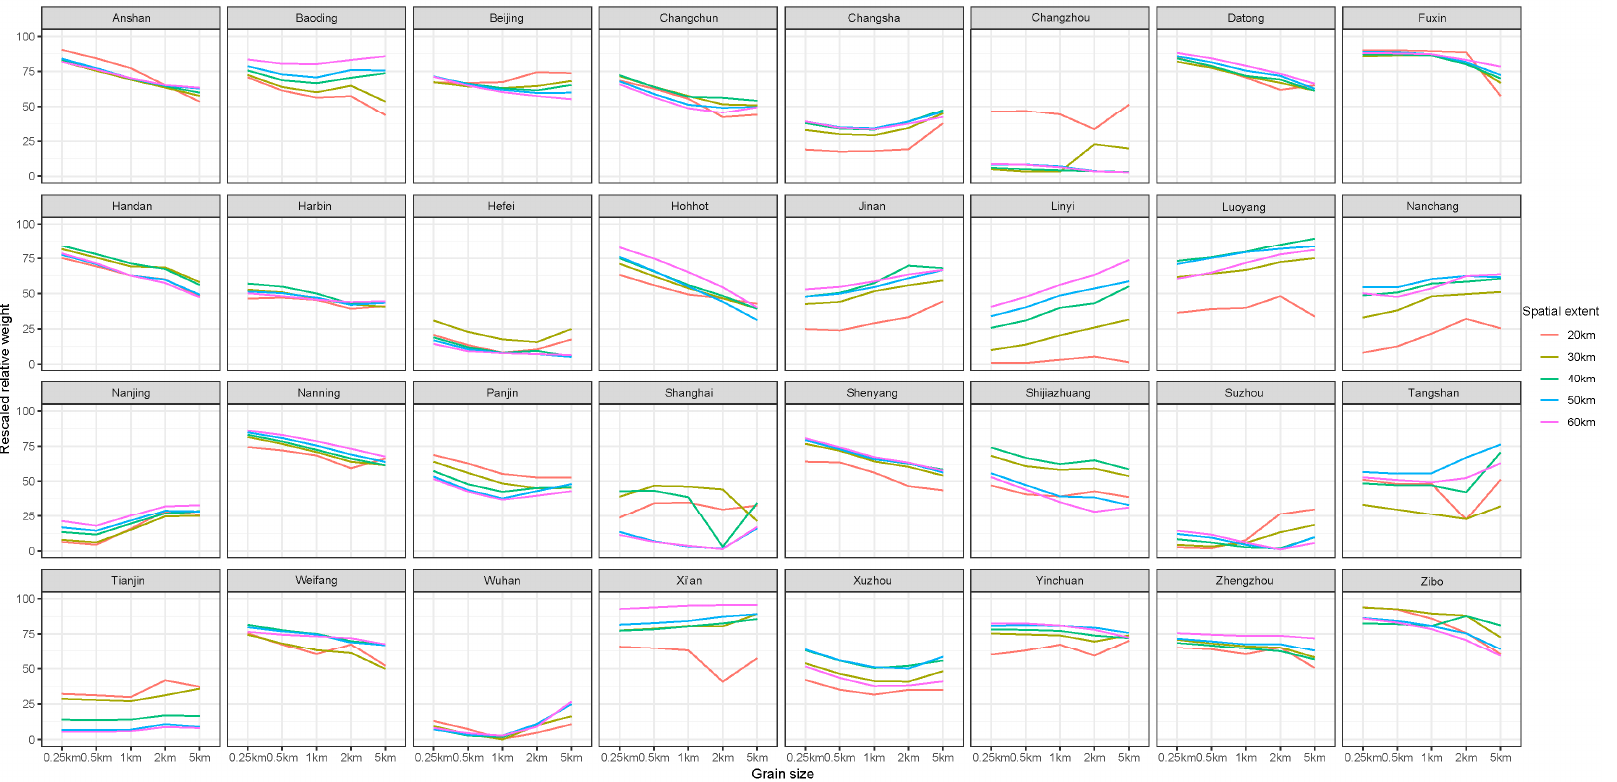
Figure A13. Relative importance of NDVI for explaning LST(Scalogram of the grain size).